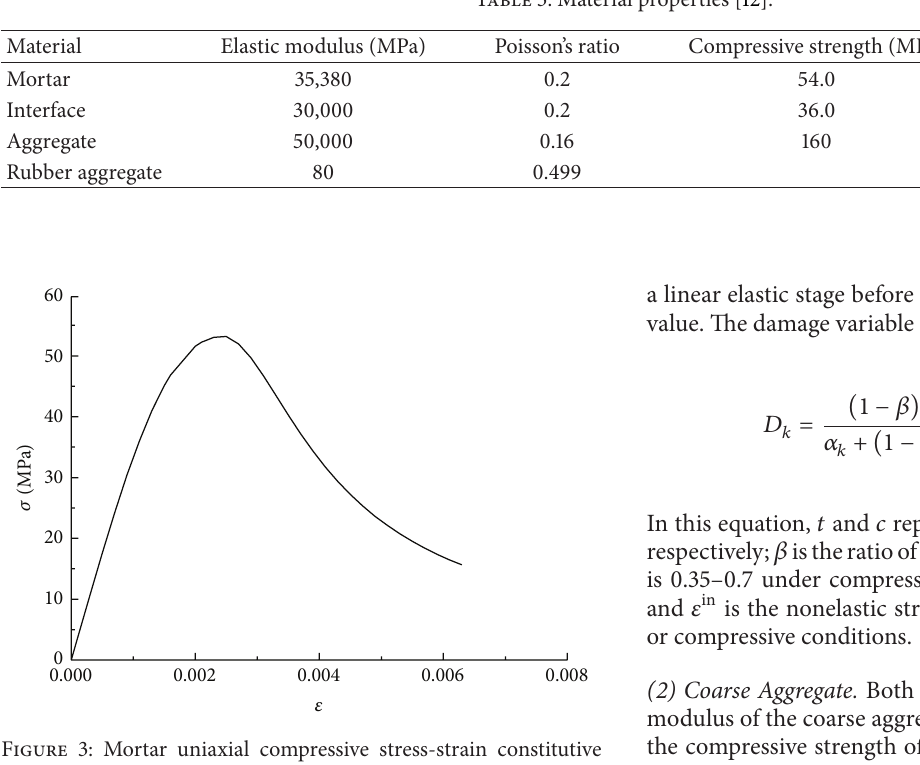
Table 3: Material properties [12].